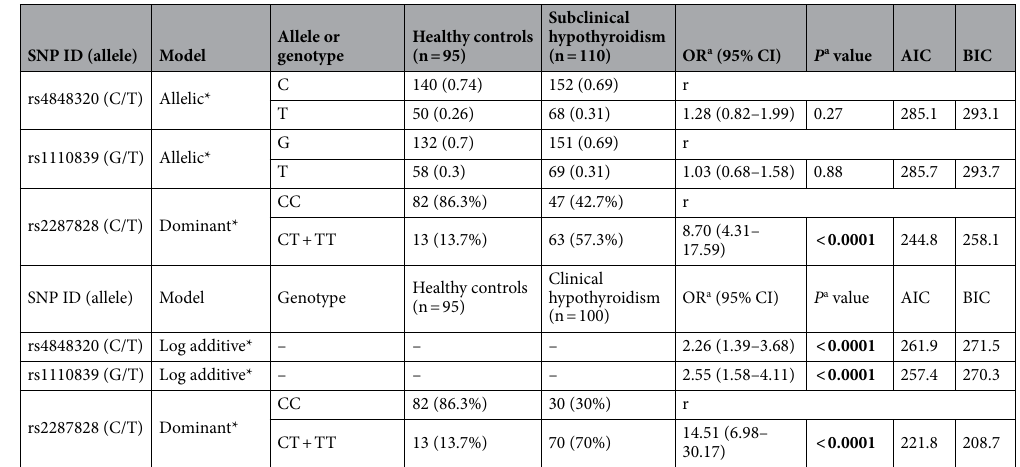
Table 3. Association of LncRNA-PAX8-AS1 rs4848320 (C/T), rs1110839 (G/T), and LAIR-2 rs2287828 (C/T) with subclinical and clinical hypothyroidism. Values are expressed as number (percentage). a adjusted for age and sex in a logistic regression model using SNPstats online software. * refers to the model that best matches the data and was chosen using the lowest Akaike information criterion (AIC) and Bayesian information criterion (BIC) values compared to other genetic models. P values in bold means statistical significance, P < 0.05.